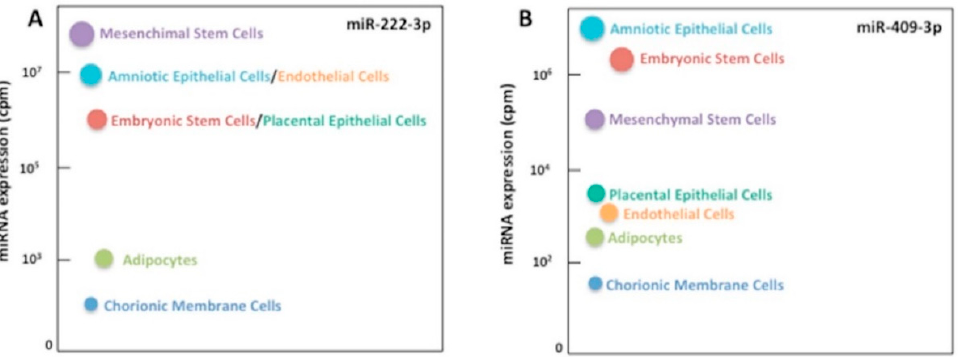
Figure 5. Expression of miR-222-3p and miR-409-3p in specific primary cell samples. Expression of miR-222-3p ( A ) and miR-409-3p ( B ) was enriched in mesenchymal stem cells, amniotic and placental epithelial cells, endothelial cells, and embryonic stem cells; lower expression of these miRNAs was found in adipocytes and chorionic membrane cells. cpm = counts per million.